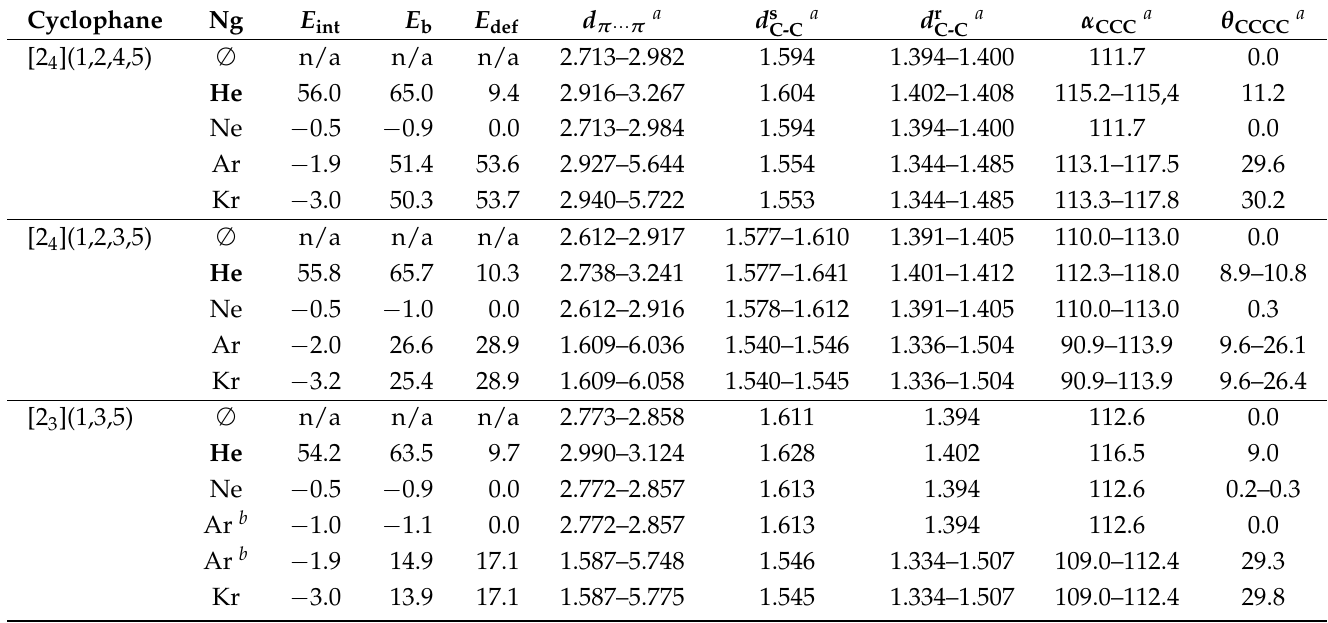
Table 4. Interaction, binding, and deformation energies (in kcal/mol), and selected geometric param- eters (in Å or degrees) for the cyclophane molecule (if ∅ mark is used) and either the Ng@cyclophane (if Ng is marked with boldface) or cyclophane · · · Ng (Ng = He, Ne, Ar, Kr) complexes obtained after geometry optimizations of the initially built Ng@cyclophane complexes.